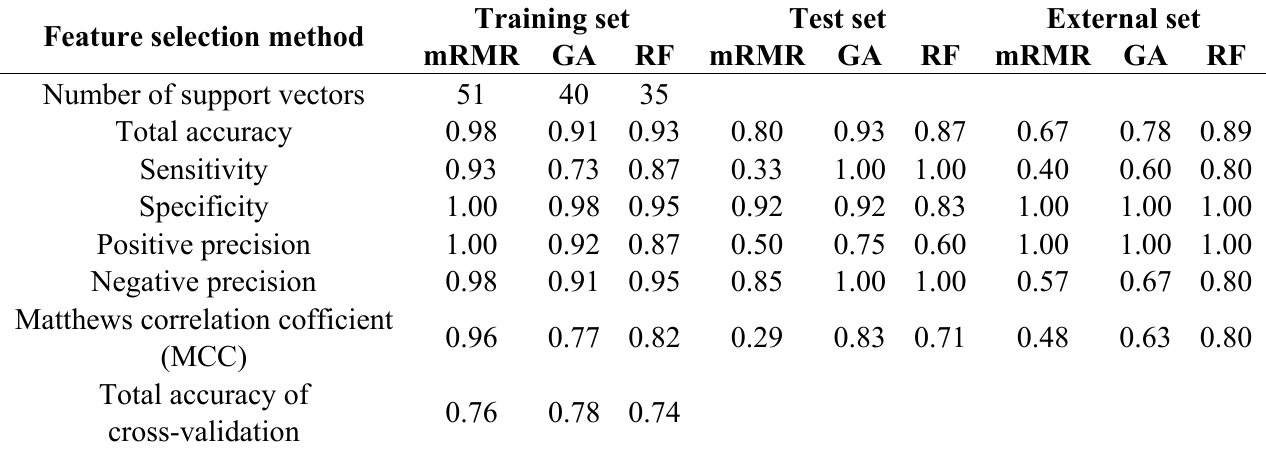
Table 3. Classification results of 3 SVM models corresponding with 3 descriptor sets selected successively via mRMR, GA and RF